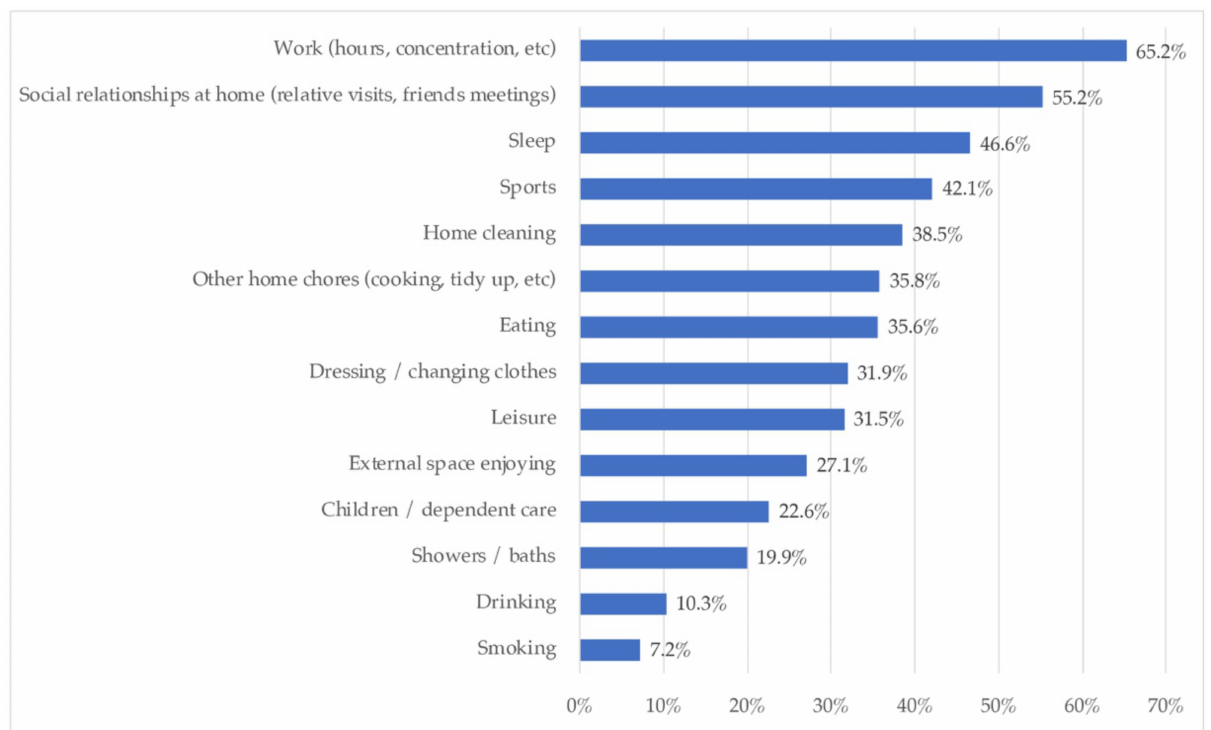
Figure 9. Main household habits that were modified during confinement. Figure 9 collected the habits that households changed during the lockdown. They declared to have changed mainly work habits (65.2%), social relations at home (55.2%), sleep (46.1%), and domestic chores: home cleaning (38.5%) and others (35.8%). Eating was also altered for 35.6%, and clothes-changing and leisure changed for almost a third of